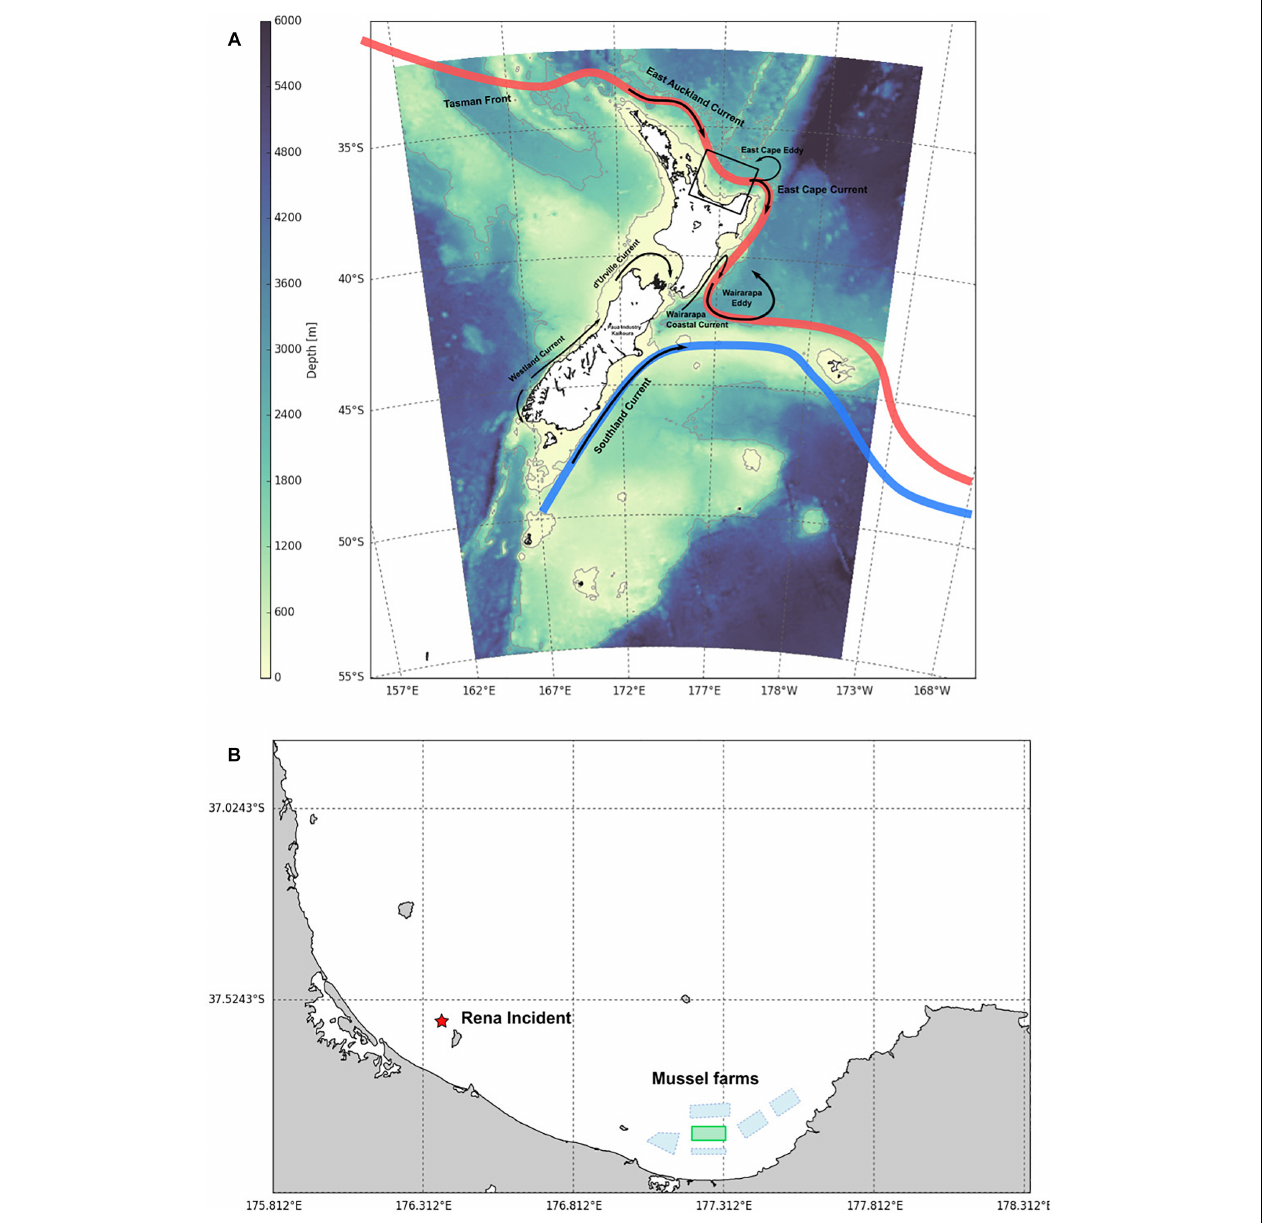
FIGURE 2 | Diagram showing the (A) NZ maritime region and the dominant circulation and (B) regional zoom in of the Bay of Plenty region showing WMTB existing and proposed mussel farms. Adapted from https://www.moanaproject.org/nz-seafood under a Creative Commons public license Attribution-NonCommercial- ShareAlike 4.0 International (CC BY-NC-SA